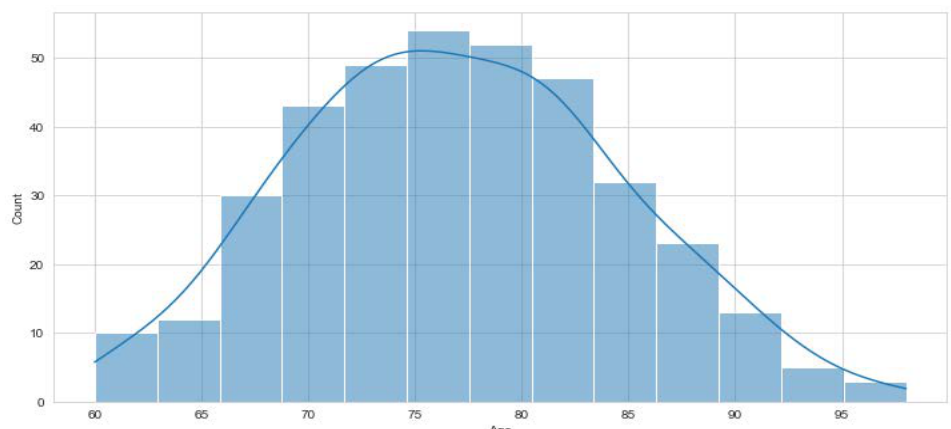
Figure 5. Histogram Graph for Distribution of ‘Age’ Column .